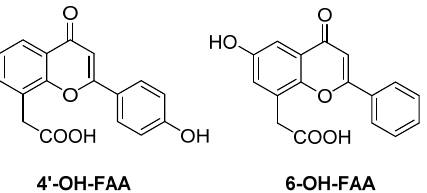
Figure 12. Representative FAA metabolites in murine cells.